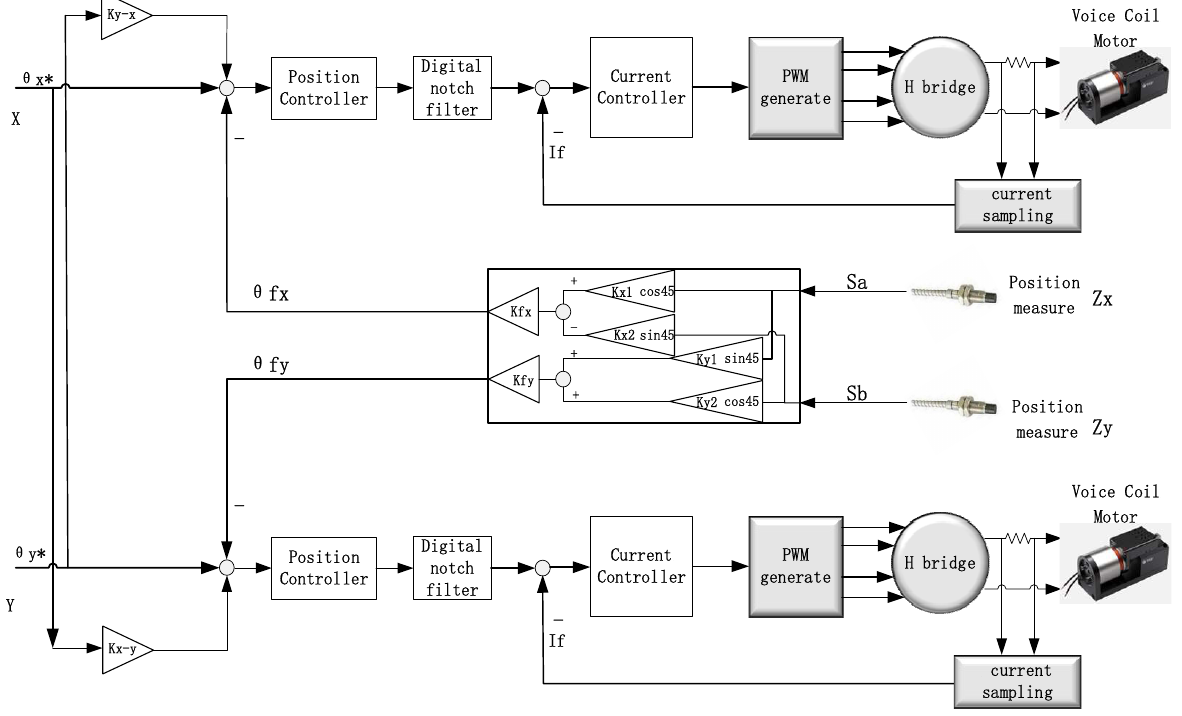
Figure 3. FSM control principle diagram.